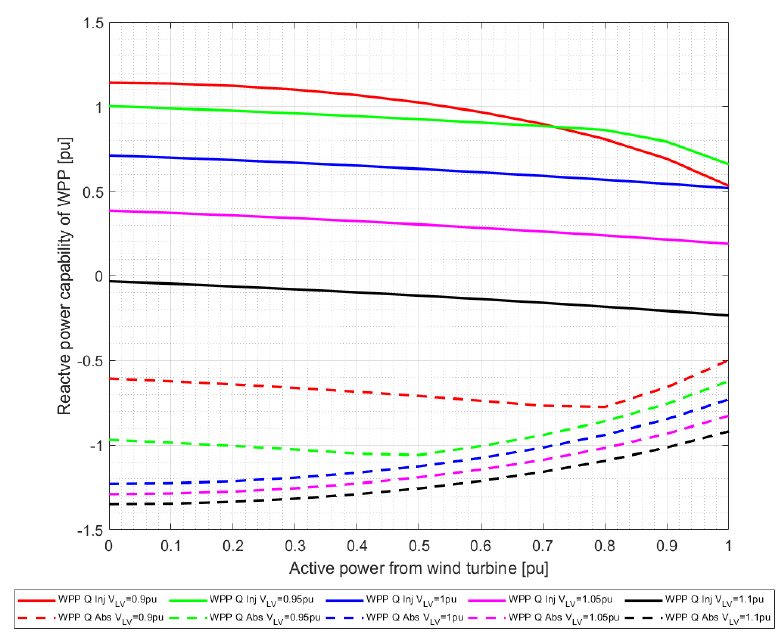
Figure 6. WPP capability curve at the low voltage (LV) end of WPP